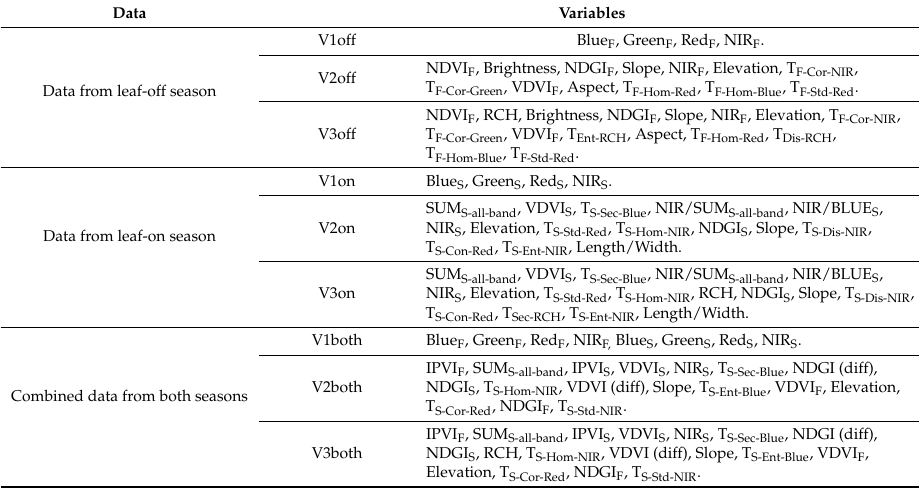
Table 3 summarized the selected variables using RF based on different data scenarios—leaf-off, leaf-on, and the combination of those seasons. V1off, V1on, and V1both represent the spectral bands only at leaf-off, leaf-on, and combination of both seasons. The selected variables in V2off, V2on, and V2both included spectral responses (spectral band or vegetation index), textural images, and topographic factors, which implies the importance of using multiple source data in land-cover classification. Considering scenario V3, three and two forest stand variables corresponding to V3off and V3on and one forest stand variable corresponding to V3both were selected, which implies that forest stand structure may be useful in improving land-cover, especially tree species classification. Table 3. Selected variables for use in land-cover